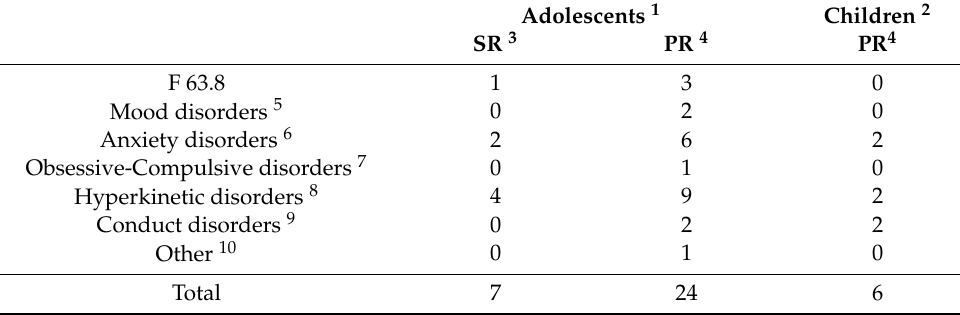
Table 4. Primary clinical diagnoses of patients meeting >5 IGD